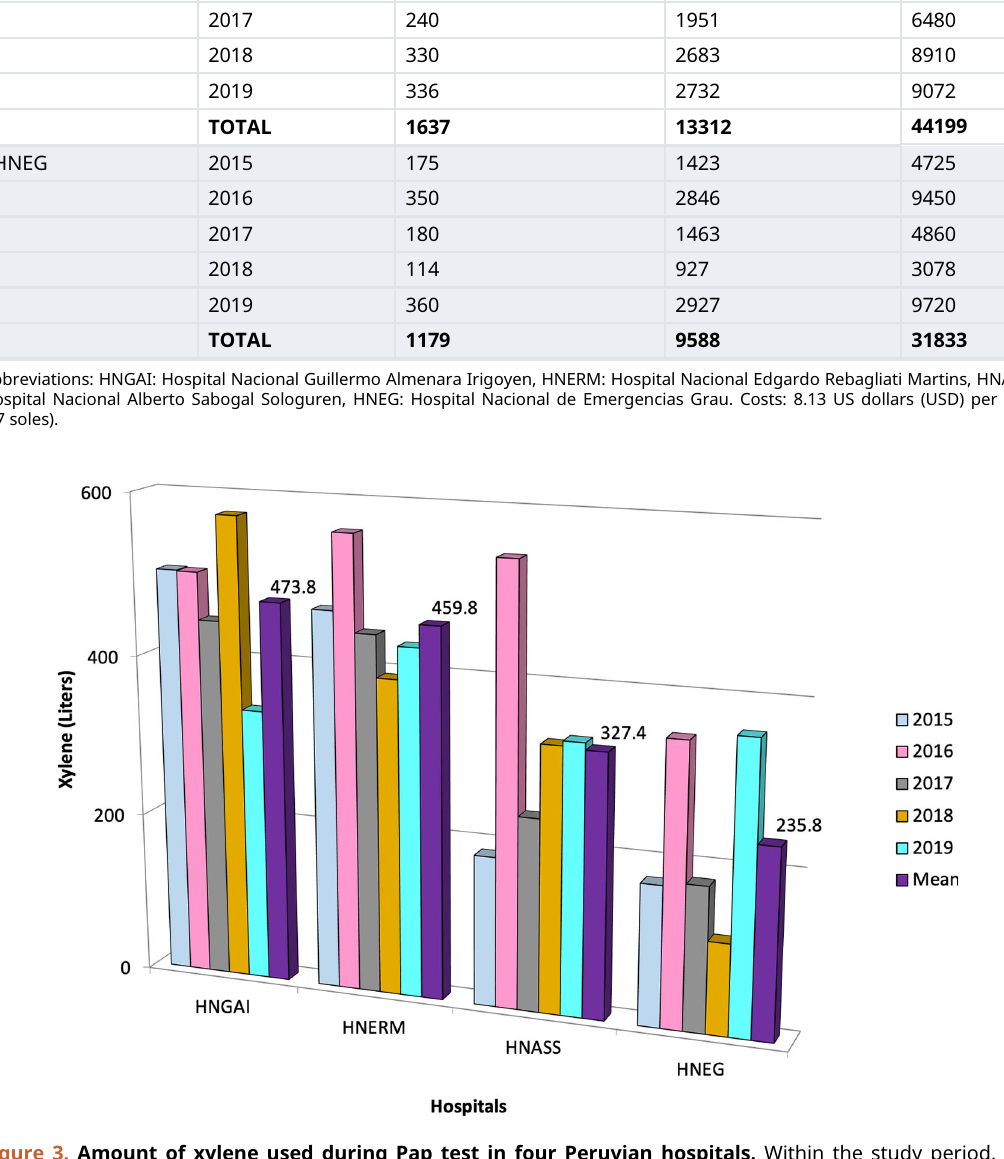
Figure 3. Amount of xylene used during Pap test in four Peruvian hospitals. Within the study period, the